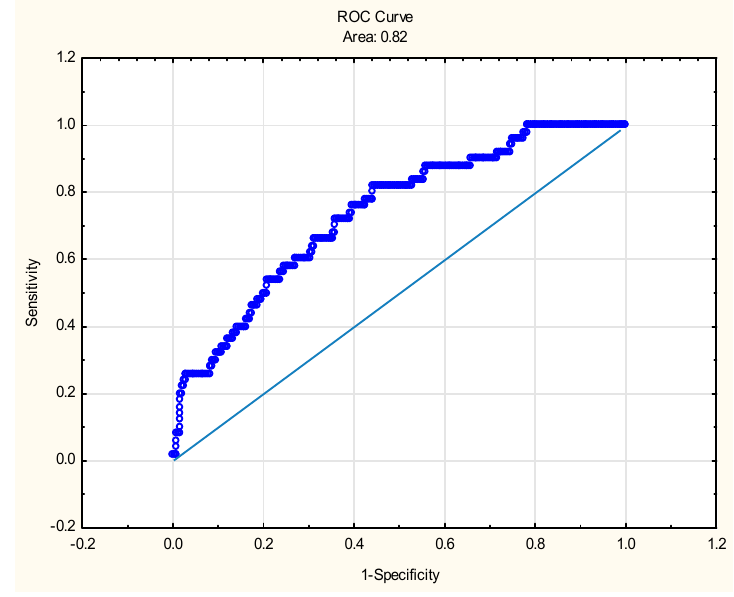
Figure 1. ROC curve for ADD model.